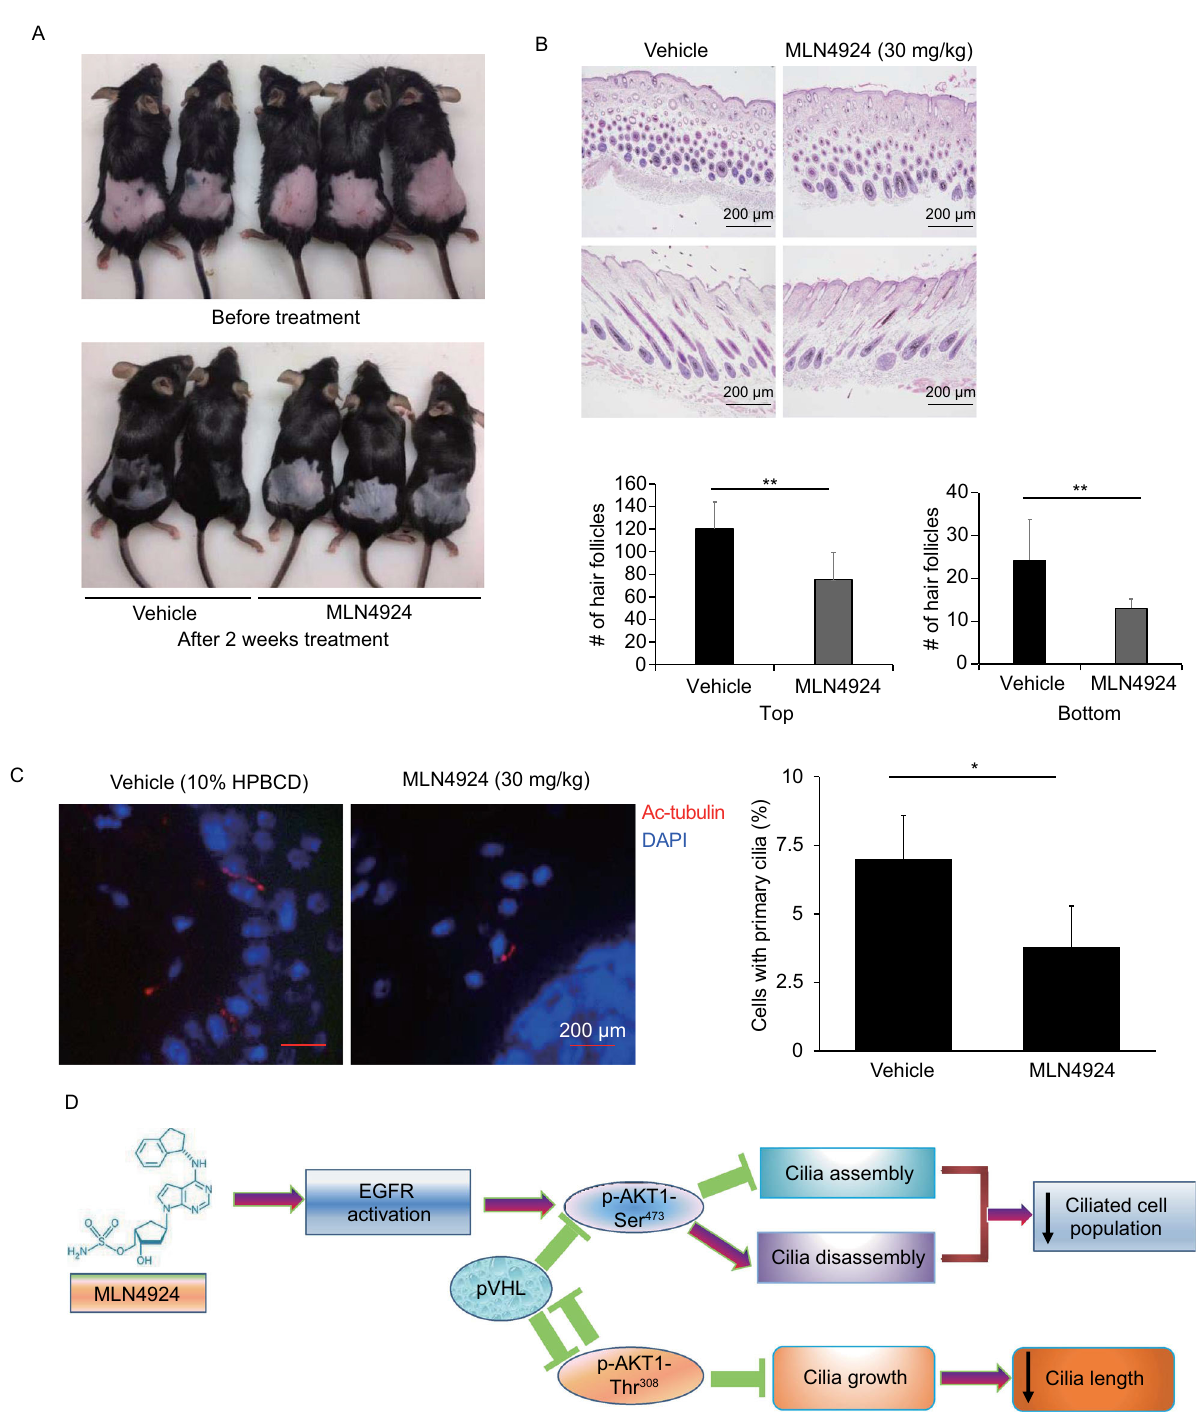
Figure 7. MLN4924 inhibits hair regrowth by blocking ciliogenesis in mouse skin. (A) The dorsal hairs of mice were removed on day 1. On day 2, mice were injected with MLN4924 (30 mg/kg) along with vehicle control, once a day, 5 days per week for 2 weeks. The photo images were taken before and after 2 weeks of treatment. (B and C) Mice skin were harvested at the end of 2-week treatment, fi xed, embedded, sectioned, stained with H & E and photographed. The hair follicles were counted and result blotted (B), or skin sections were stained with immono fl uorescence using ciliary marker acetylated tubulin (red), positive cells were counted. All scale bars are 200 µm. Shown is mean ± SEM from randomly selected 5 skin areas harvested from at least two mice. (D) The working model. See text for